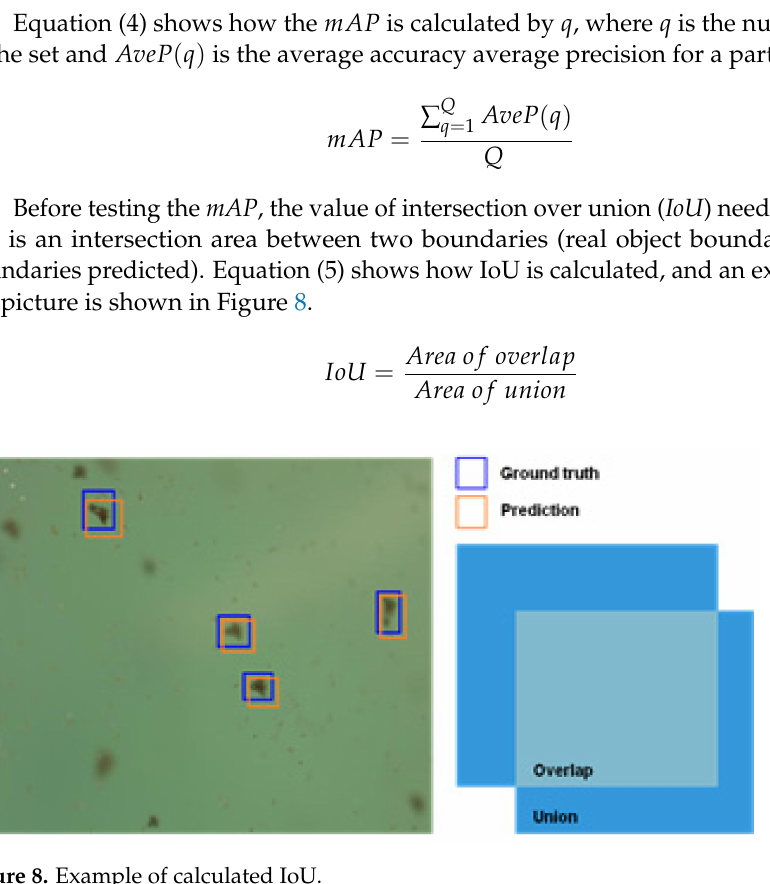
Figure 8. Example of calculated